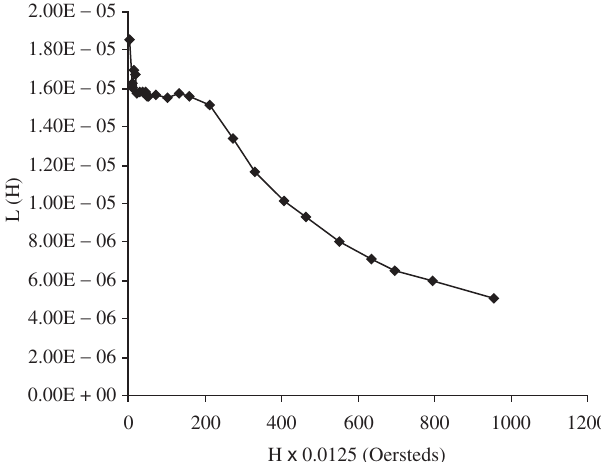
Figure 7. Variation of inductance in relation to the applied field of stress annealed alloys, at a frequency of 7.5